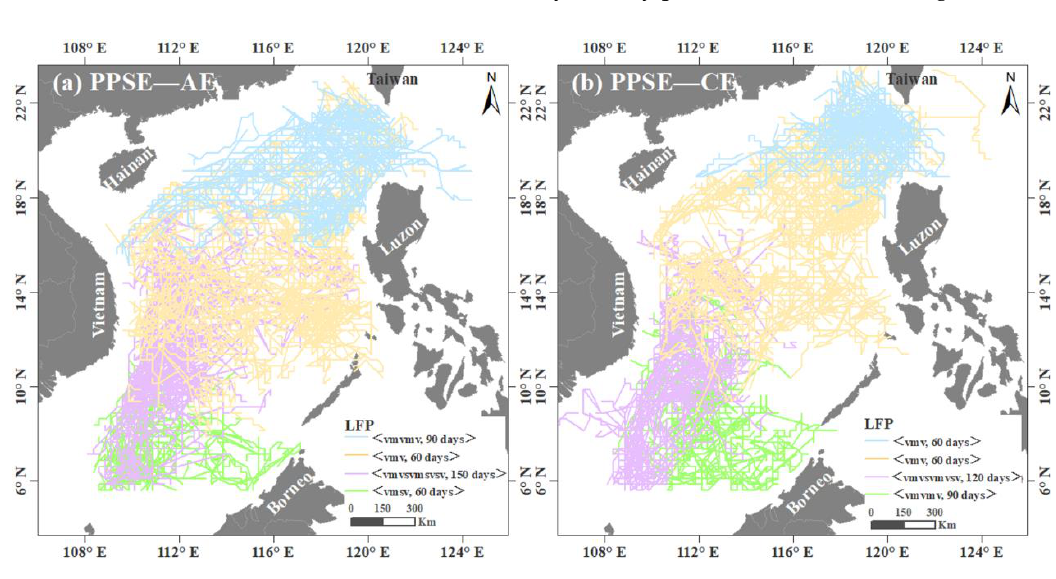
Figure 6. The LFPs for the structural evolution of AE ( a ) and CE ( b ) in the SCS based on the PPSE algorithm.